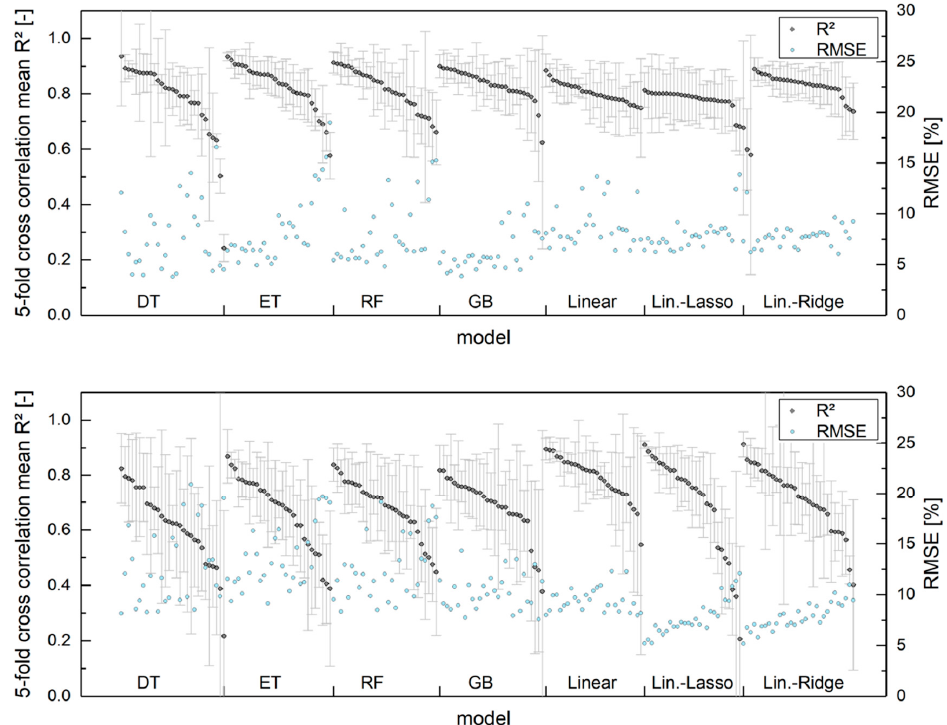
Figure 6. Overview on the models’ average performances for the histogram ( top ), and texture-based models ( bottom ) as R 2 (left axis) and RMSE values (right axis); error bars indicate the standard deviation of the average 5-fold cross validation training.